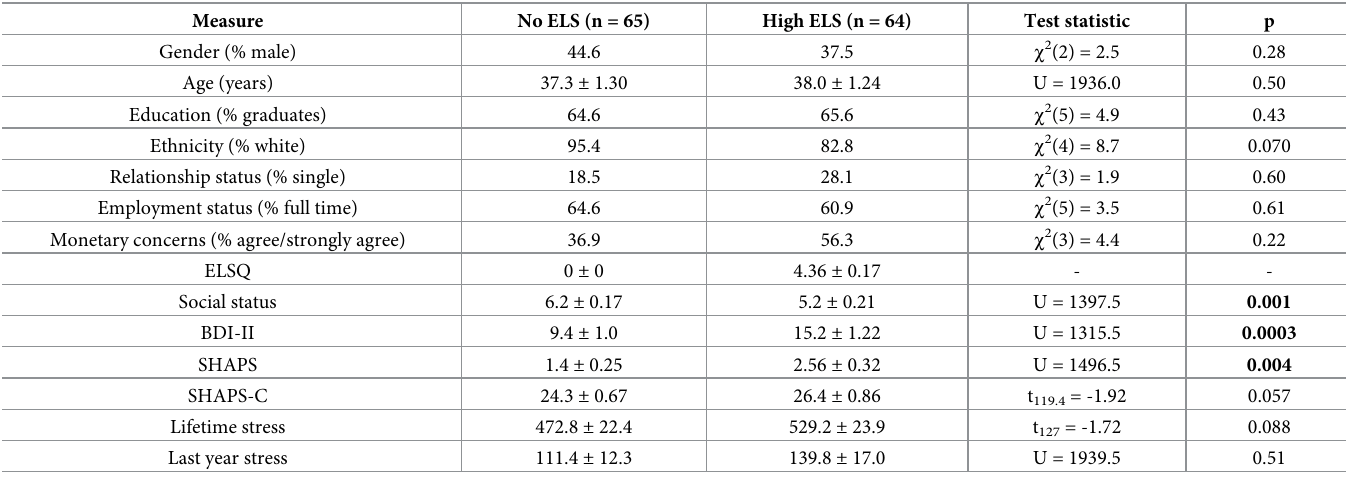
Table 1. Demographic and self-report measures in the study population.